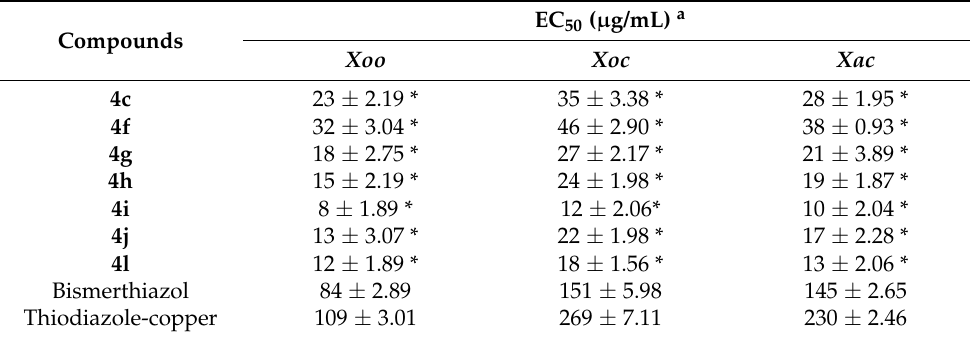
Table 2. The EC 50 values of some of the target compounds against Xanthomonas oryzae pv. oryzae , Xanthomonas oryzae pv. oryzicolaby , and Xanthomonas axonopodis pv. citri .